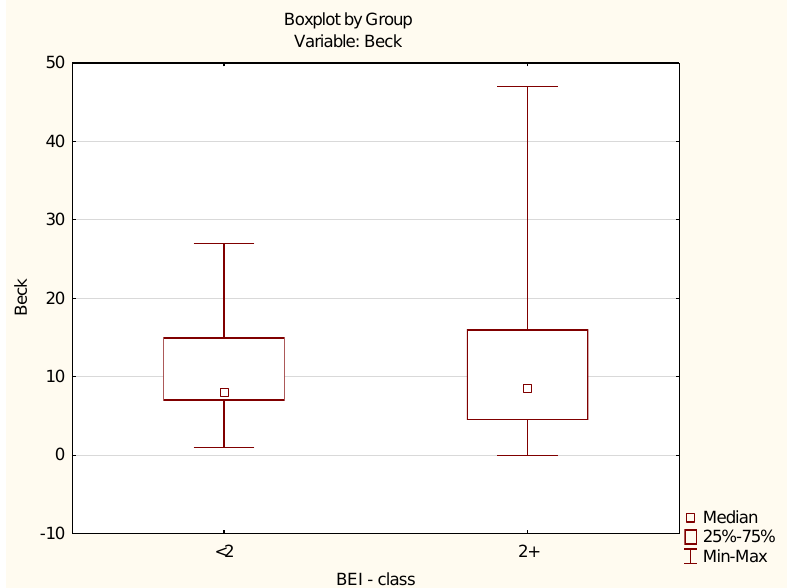
Figure 4. Summary of the BDI scores for the study and control groups.